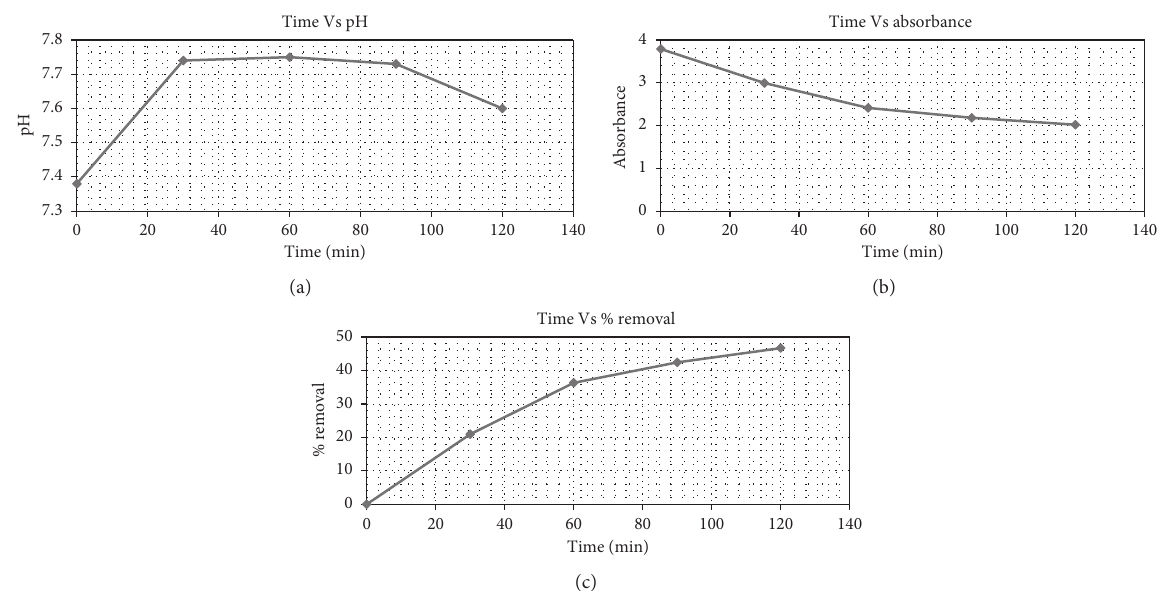
Figure 10: (a) Plot of pH with respect to time over 140min period. (b) Plot of absorbance with respect to time over 140min period. (c) Plot of percent removal with respect to time over 140min period.